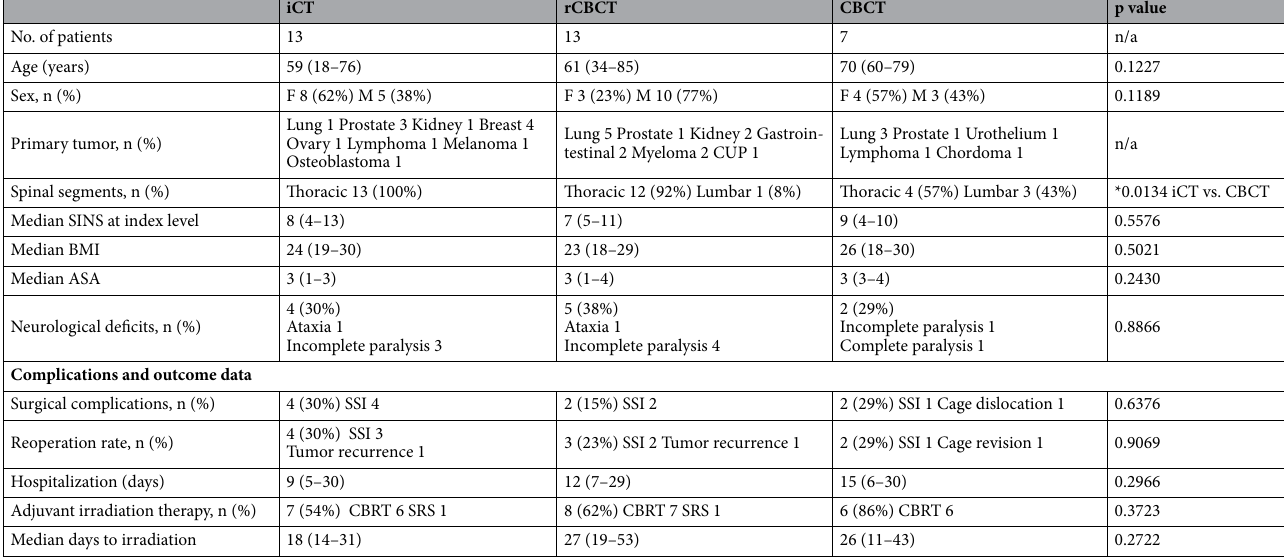
Table 1. Demographic, clinical and outcome data. Values are given in total number with percentages or as median with total range, as appropriate. ASA American Society for Anesthesiology, BMI Body Mass Index, CBRT Conventional Beam Radiation Therapy, CUP Cancer of unknown primary, SINS Spinal Instability Neoplastic Score, SRS Stereotactic radiosurgery, SSI Surgical Site Infections.